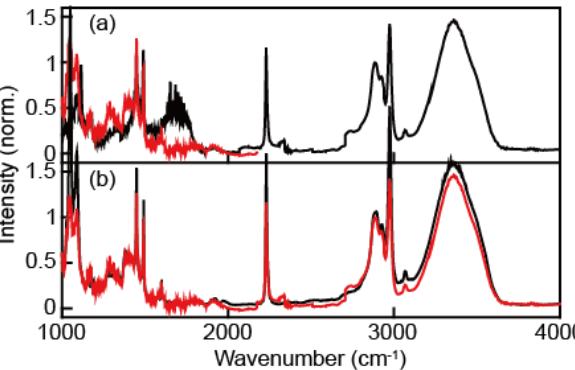
Figure 4. ( a ) The IR absorption spectra of water:benzonitrile (=1:1, volume ratio) solution measured using our continuum IR pulse obtained with a monochromator and a 2.4 µ m IR long-pass filter (black) or 4.5 µ m IR long-pass filter (red). ( b ) Comparison between the FTIR absorption spectrum (black) and that obtained with a continuum IR pulse (red).